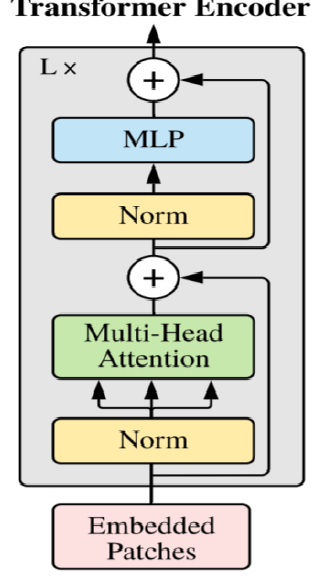
Figure 7. Transformer encoder structure.